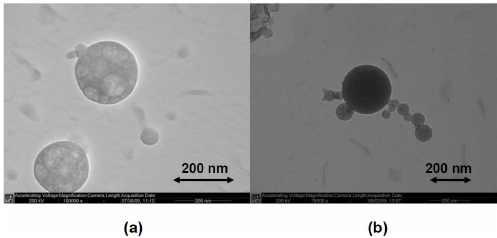
Fig. 6. TEM images of aerosol particles before (a) and after (b) Figure 6. TEM images of aerosol particles before (a) and after (b) annealing at 300 °C in the annealing at 300 ◦ C in the tube furnace. The aerosol particles were tube furnace. The aerosol particles were generated by atomizing the Ca(HCO 3 ) 2 solutions and generated by atomizing the Ca(HCO 3 ) 2 solutions and dried before dried before deposition on the TEM grids. deposition on the TEM